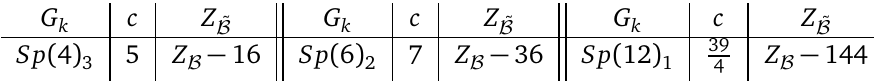
Table 11: List of C-type WZW models satisfying the supersymmetry conditions after the fermion- ization. Each of three models in this table has a (cid:90) ( Z − Z ) is constant, their fermionic models are expected to have supersymmetric Ramond B (cid:101) B vacua.